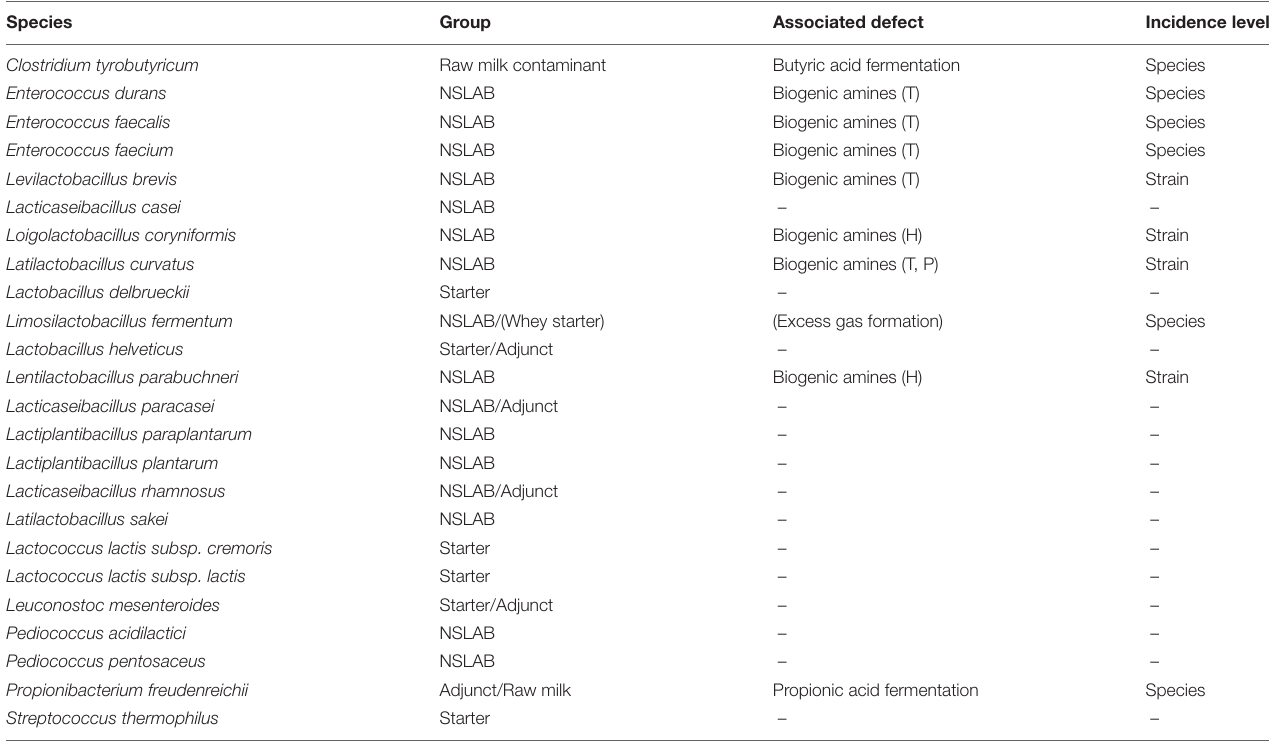
TABLE 1 | Selected species/subspecies and their impact on cheese quality.